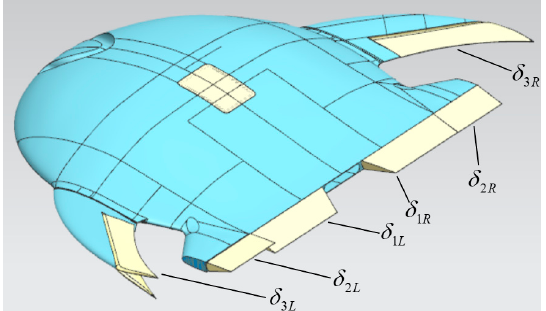
Figure 1. The saucer-shaped unmanned aerial vehicle (UAV) with multiple control surfaces.